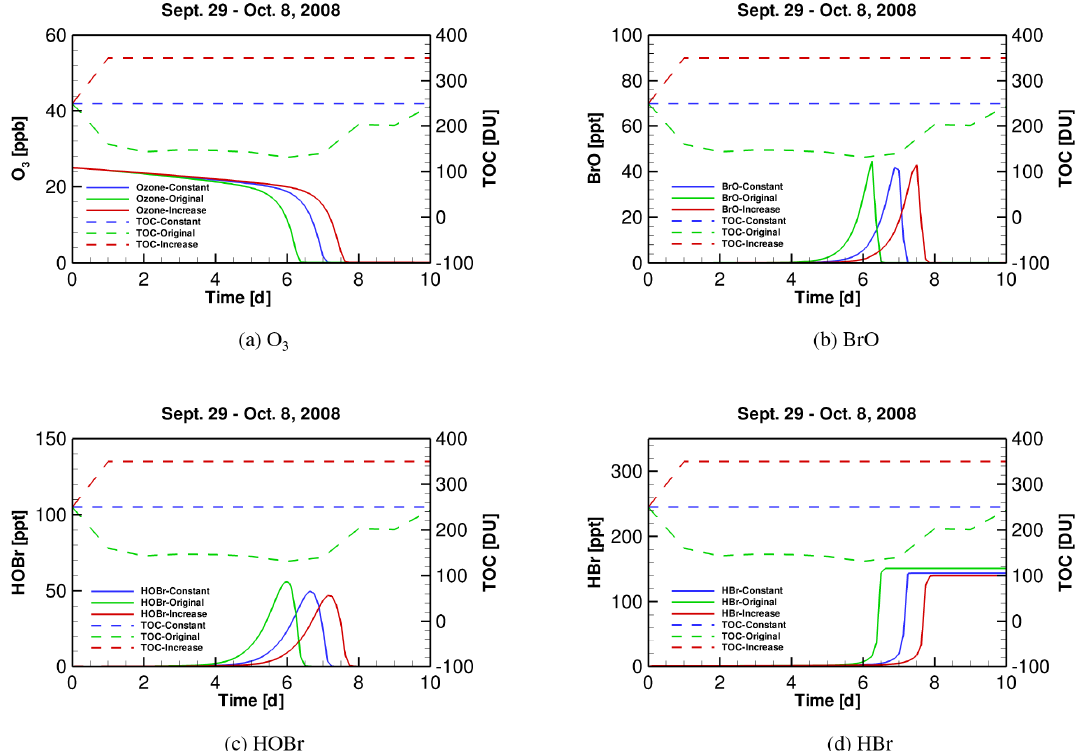
Figure 5. Time series of (a) tropospheric ozone, (b) BrO, (c) HOBr and (d) HBr during ODEs under the conditions of October 2008, implementing three different TOC profiles (i.e., original, “constant” and